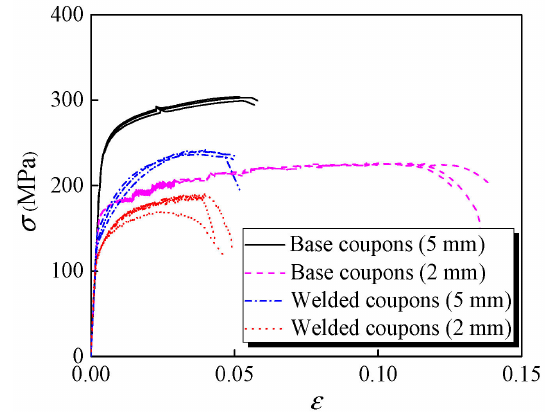
Figure 4. Measured stress-strain